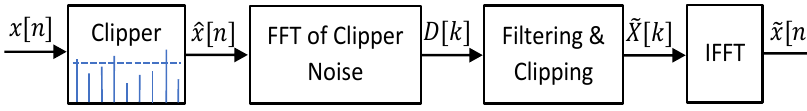
Figure 2. Top-level view of